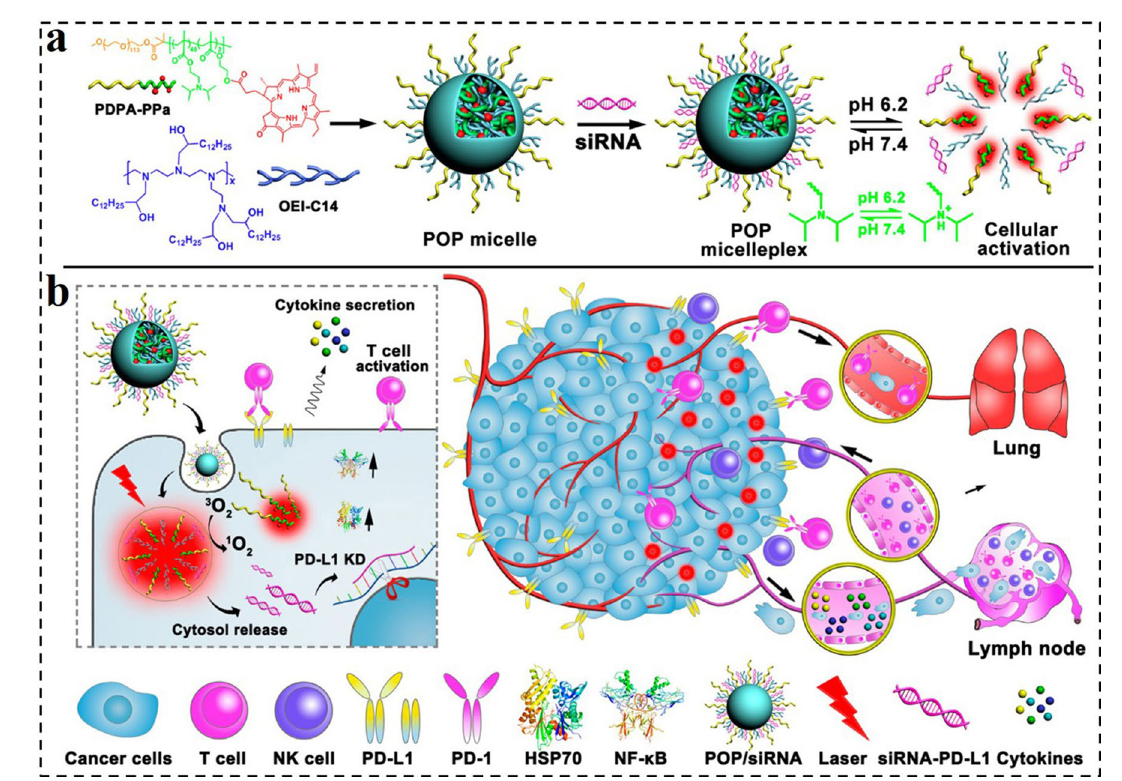
Fig. 5 a Chemical structure of the acid-activatable POP micelleplexes co-loaded with PPa and siRNA. The micelleplexes can be dissociated in an acidic microenvironment due to the protonation of the tertiary amino groups of PDPA. b Cartoon schematic of POP − PD-L1 micelle- plex-mediated photodynamic immunotherapy. The POP − PD-L1 micelleplexes induce ROS generation upon PDT. ROS consequently induces an adaptive immune response by eliciting HSP70 and NF-κB expression, triggering pro-inflammatory cytokine secretion and recruiting tumor- infiltrating T cells. The PDT-induced antitumor immune response can be further enhanced by RNAi of PD-L1 [160]. Copyright 2016, American Chemical